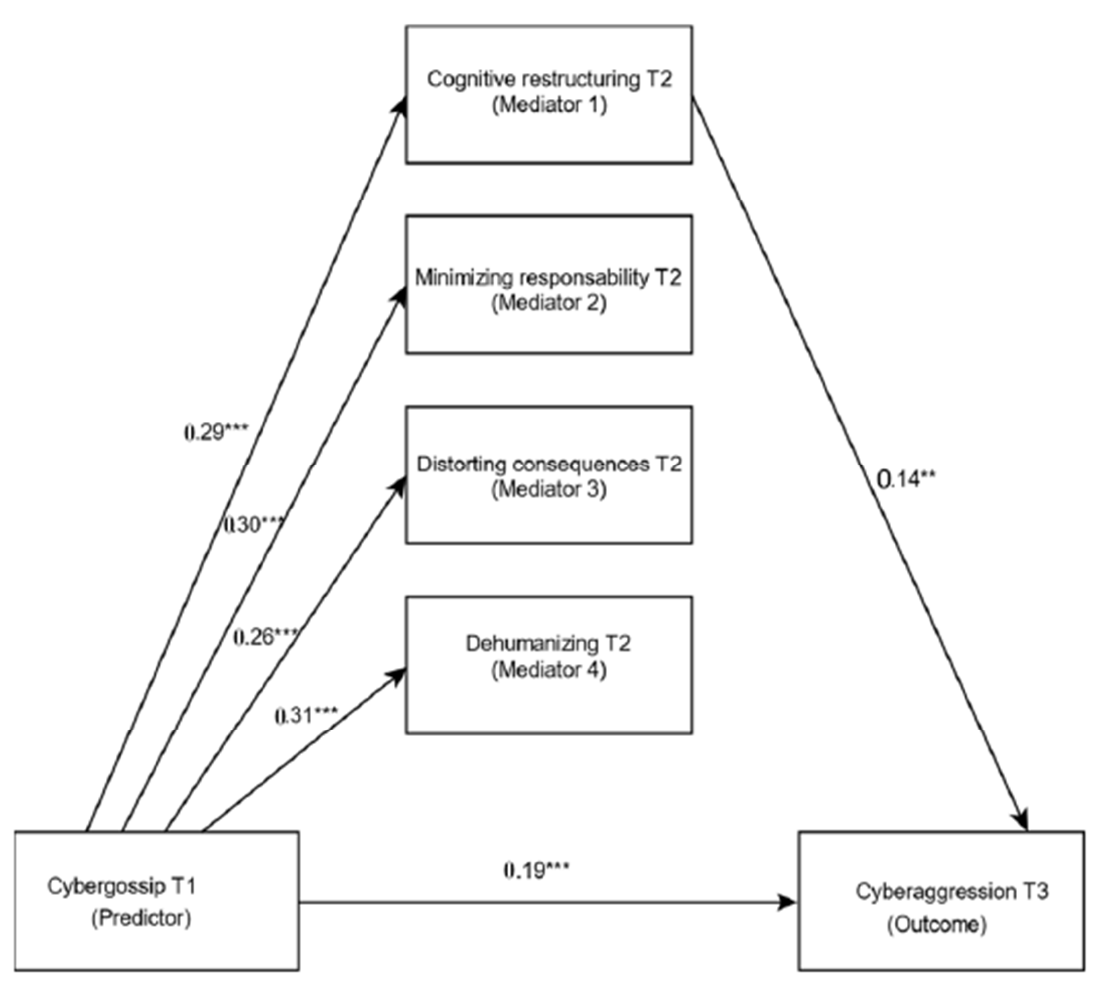
Figure 2. Results in the pathways of the model. Note: **p<0.01; ***p<0.001.